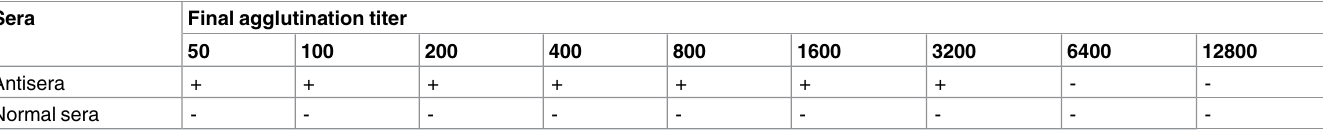
Table 1. Leptospiral agglutinating activity of antisera Sera Final agglutination